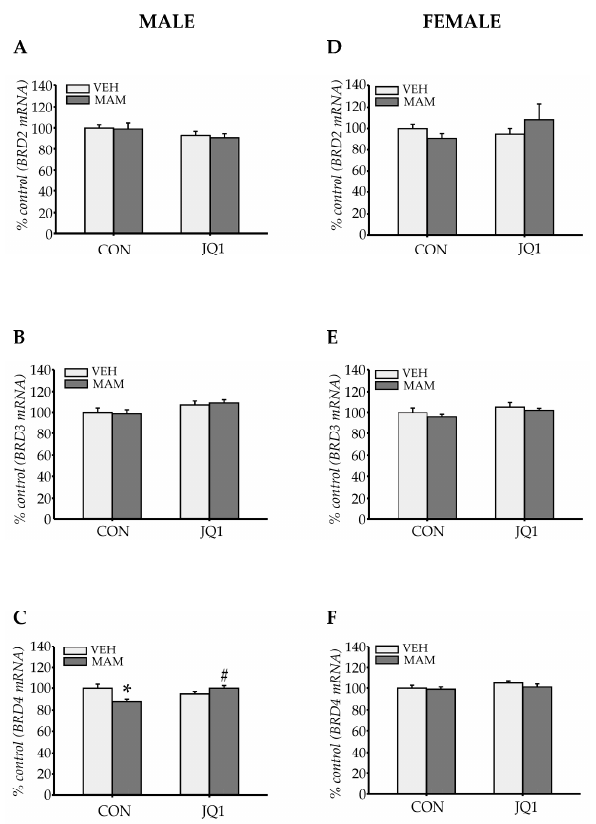
Figure 5. The effects of an adolescent JQ1 administration on BRD gene expression in the adult medial prefrontal cortex in the MAM-E17 model of schizophrenia. The rats (males: A – C and females: D – F ) were exposed to JQ1 or vehicle (CON) in early adolescence (P23–P29), and the analyses were performed in rats at P110. ( A – C ) BRD2 , BRD3 , and BRD4 expression in males, respectively. ( D – F ) BRD2 , BRD3 , and BRD4 expression in females, respectively. The data are expressed as percentage of VEH-CON. Each data point represents the mean ± SEM; n = 6 per group; * p < 0.05 vs . VEH-CON, # p < 0.05 vs . MAM-CON (two-way ANOVA followed by a Tukey test).